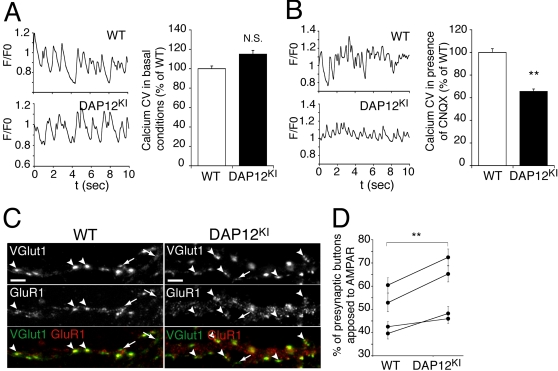
Neurons from DAP12KI P0 pups cultured without microglia develop synaptic alterations.(A) Coefficients of variation (CV, see Methods), in basal conditions, of the fluctuations of intracellular calcium concentration, in neurons cultured from WT and DAP12KI animals. Left, original recordings from individual neurites; right, averaged data from three independent experiments (>200 neurites recorded/experiment). (B) Coefficients of variation in presence of CNQX, an AMPAR antagonist. Left, original recordings from individual neurites; right, averaged data from three independent experiments (>200 neurites recorded/experiment); **p<0.0001 Mann-Whitney t test. (C) Double detection of VGlut1 (green or upper line) and GluR1 (red or middle line) immunoreactivity, and overlay of both stainings (lower line) in neuronal cultures from WT and DAP12KI animals. Arrowheads: apposition of VGlut1 and GluR1 puncta; arrows: VGlut-1 puncta not apposed to GluR1 clusters. Scale bar: 5 µm. (D) Quantitative analysis of VGlut-1 and GluR1 clusters association in four pairs of cultures from WT and DAP12KI pups. At least 40 dendrites were analyzed for each culture. **p<0.0001, two-way ANOVA.